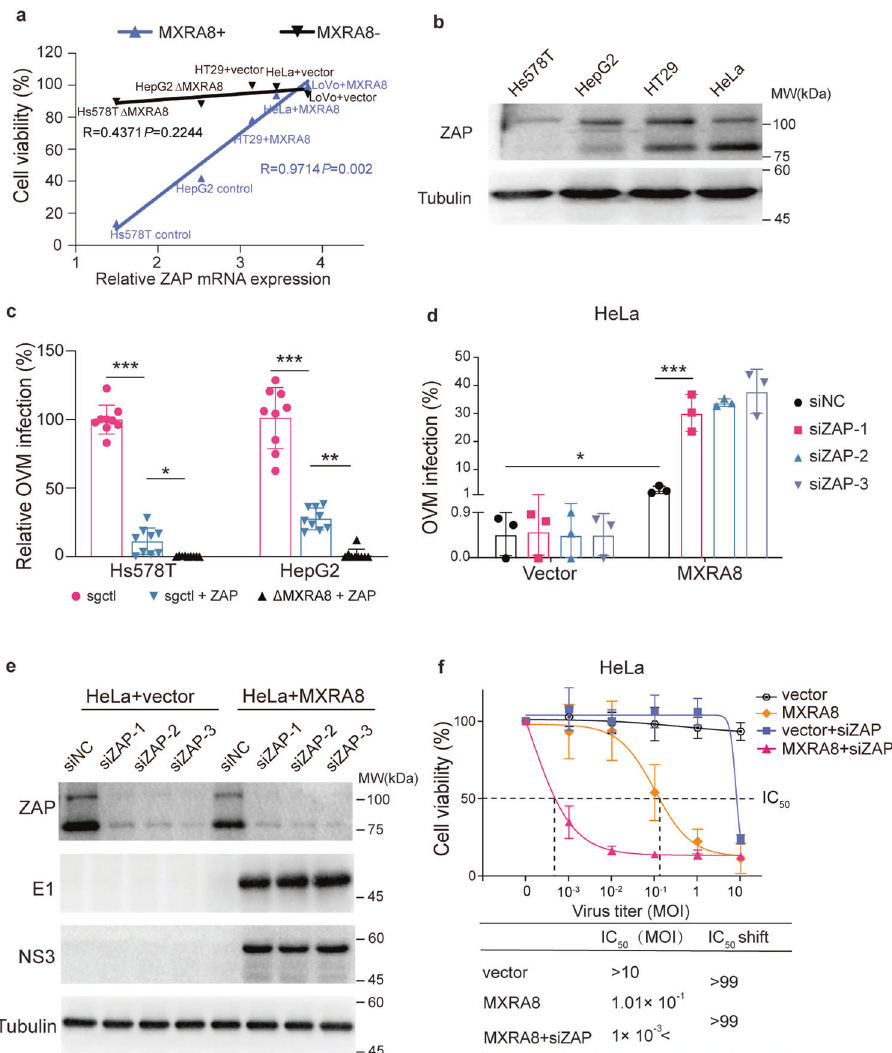
Fig. 5 The tumor selectivity of OVM is modulated by a comprehensive effect of MXRA8 and ZAP. a Spearman ’ s correlation coef fi cient of cell viability under OVM treatment and ZAP expression levels. R indicates the Spearman ’ s correlation coef fi cient. mRNA expression levels of ZAP in tumor cell lines were retrieved from the CCLE database. b The protein expression levels of ZAP in HepG2, Hs578T, HeLa, and HT29 cells. c The infection rates of OVM-GFP in sgCtrl, sgCtrl + ZAP, Δ MXRA8 + ZAP Hs578T and HepG2 cells (MOI of 0.1) by fl ow cytometry (three experiments, n = 9; one-way ANOVA; mean ± s.d.). d, e The infection rates of HeLa cells transfected with siZAP or siNC and incubated with OVM-GFP virus (three experiments, n = 3; one-way ANOVA; mean ± s.d.). The protein expression levels of ZAP, NS3, and E1 were measured by Western blot.